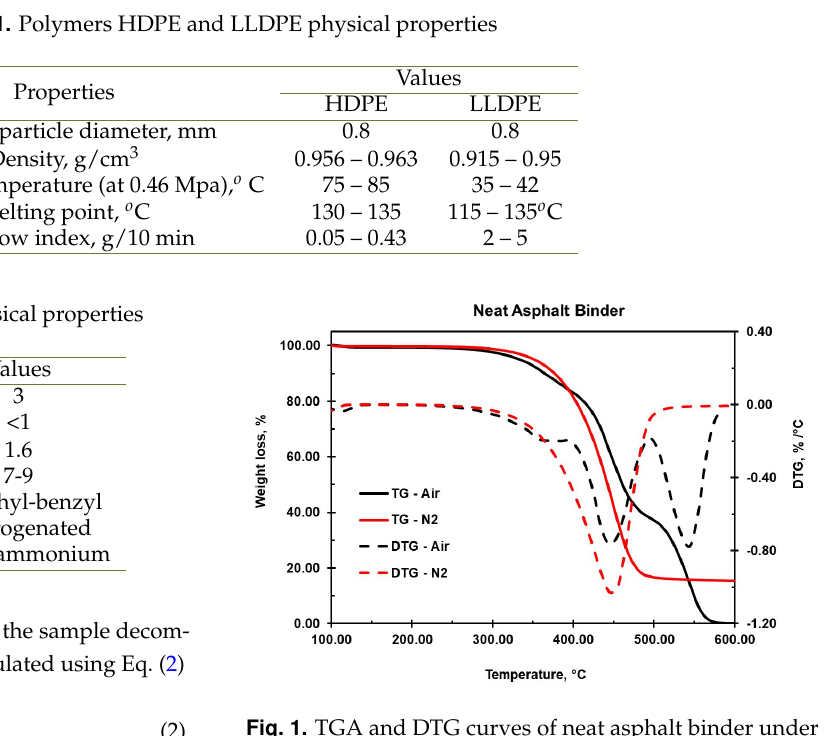
Fig. 1. TGA and DTG curves of neat asphalt binder under air and N 2